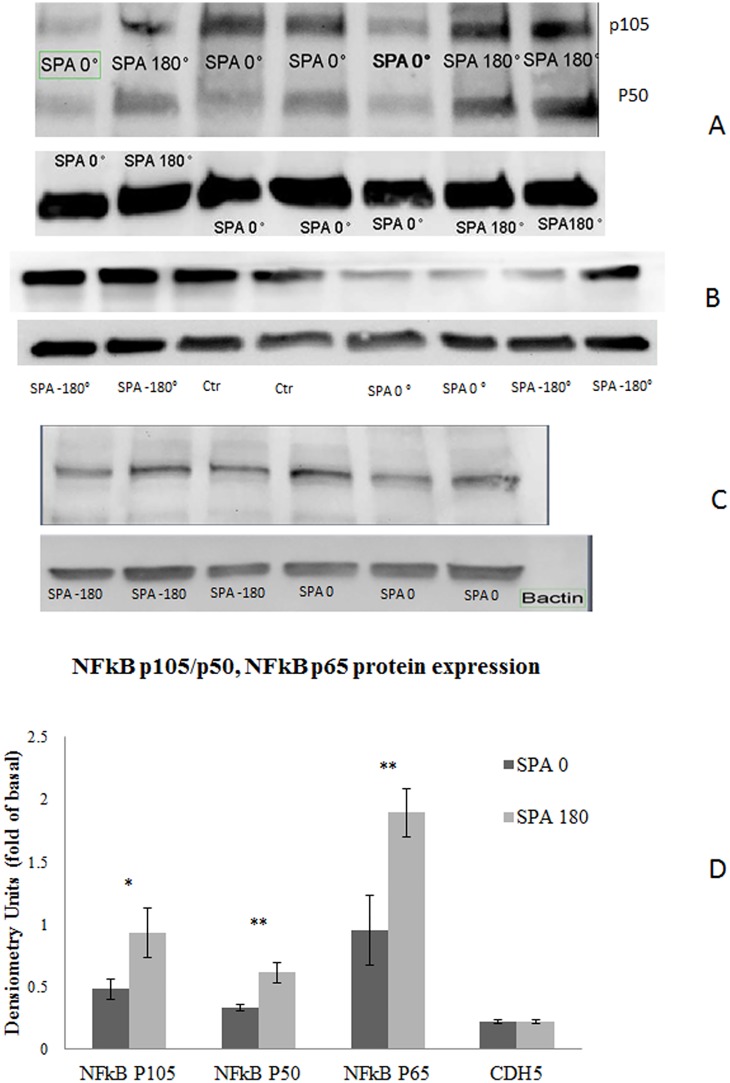
SPA modulates the protein expression levels of NFkB p105/p50 and NFkB p65 but does not affect CDH5.BAEC monolayer were exposed to WSS and CS with either SPA = 0 or SPA = -180 during 7 hours. Cell lysates from different samples (n = 6 each condition) were separated in gradient SDS-PAGE, and the proteins were transferred to nitrocellulose membranes. Nitrocellulose membranes were split into two parts for immunoblotting with NFKB p105/p50 or NFkB p65 using βactin as the endogenous control. Representative blots are shown in Fig 6. Samples were analysed by densitometry and normalized by the βactin control; then the relative protein expressions at SPA = -180 and SPA = 0 were compared. The bar graphs in (A) represent the quantification of 6 individual experiments (mean ± SEM). SPA = -180 increases the expression of NFκB p50 by 1.9 fold compared to SPA = 0 (p = 0.001) and the expression of NFκB p105 by 1.98 fold (p = 0.058). The bar in (B) suggest that SPA = -180 increase the expression of the transcriptional factor NFKB p65 (n = 8) by 1.98 fold (p = 0.002) (ANOVA, all p<0.05). SPA did not affect the CDH5 protein expression levels (n = 3 for each condition) (ANOVA p>0.05) as shown in panel B.